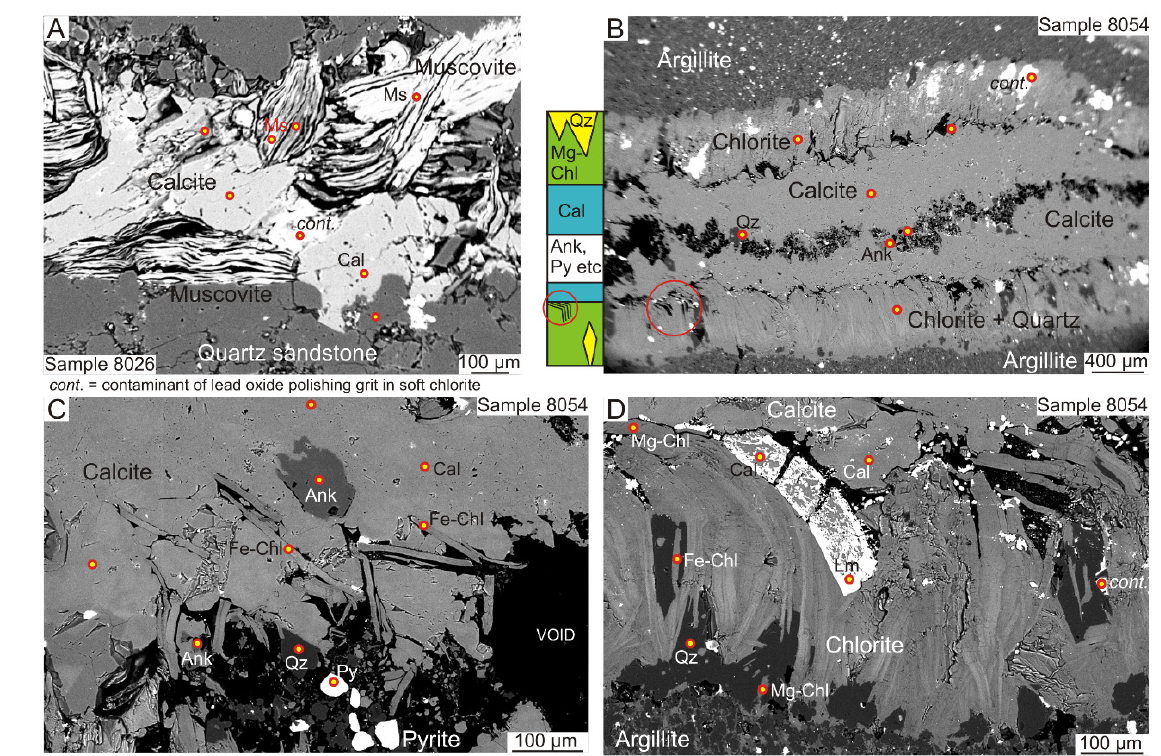
Figure 4. Backscattered electron images of veins in argillite and sandstone, Five Islands area. cont. = contaminant from polishing process. ( A ) Micaceous lamina in quartz sandstone cut by irregular calcite vein. ( B ) Composite quartz–chlorite– calcite vein with central zone of ankerite, pyrite, Fe-chlorite and quartz. Red circle shows deformed area. ( C ) Zoom of part of the central zone showing corrosion of calcite and precipitation of minerals. ( D ) Deformation of the outer Mg-chlorite zone and growth of Fe-chlorite and limonite after ankerite. Mineral abbreviations as in Table 1.